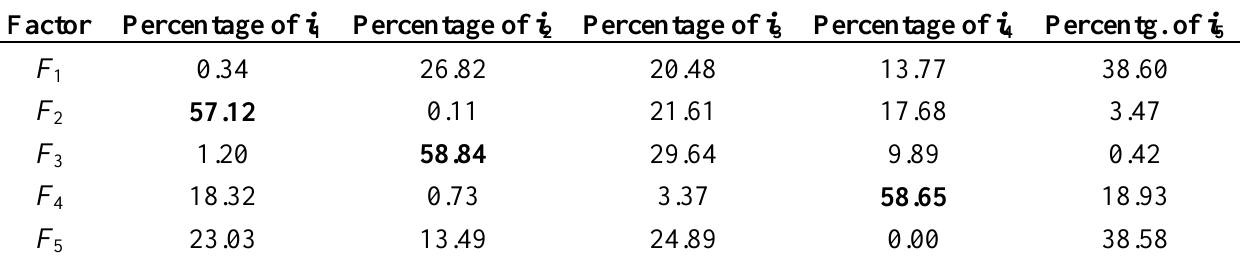
Table 6. Profile of the principal component analysis factors for the vector property. a